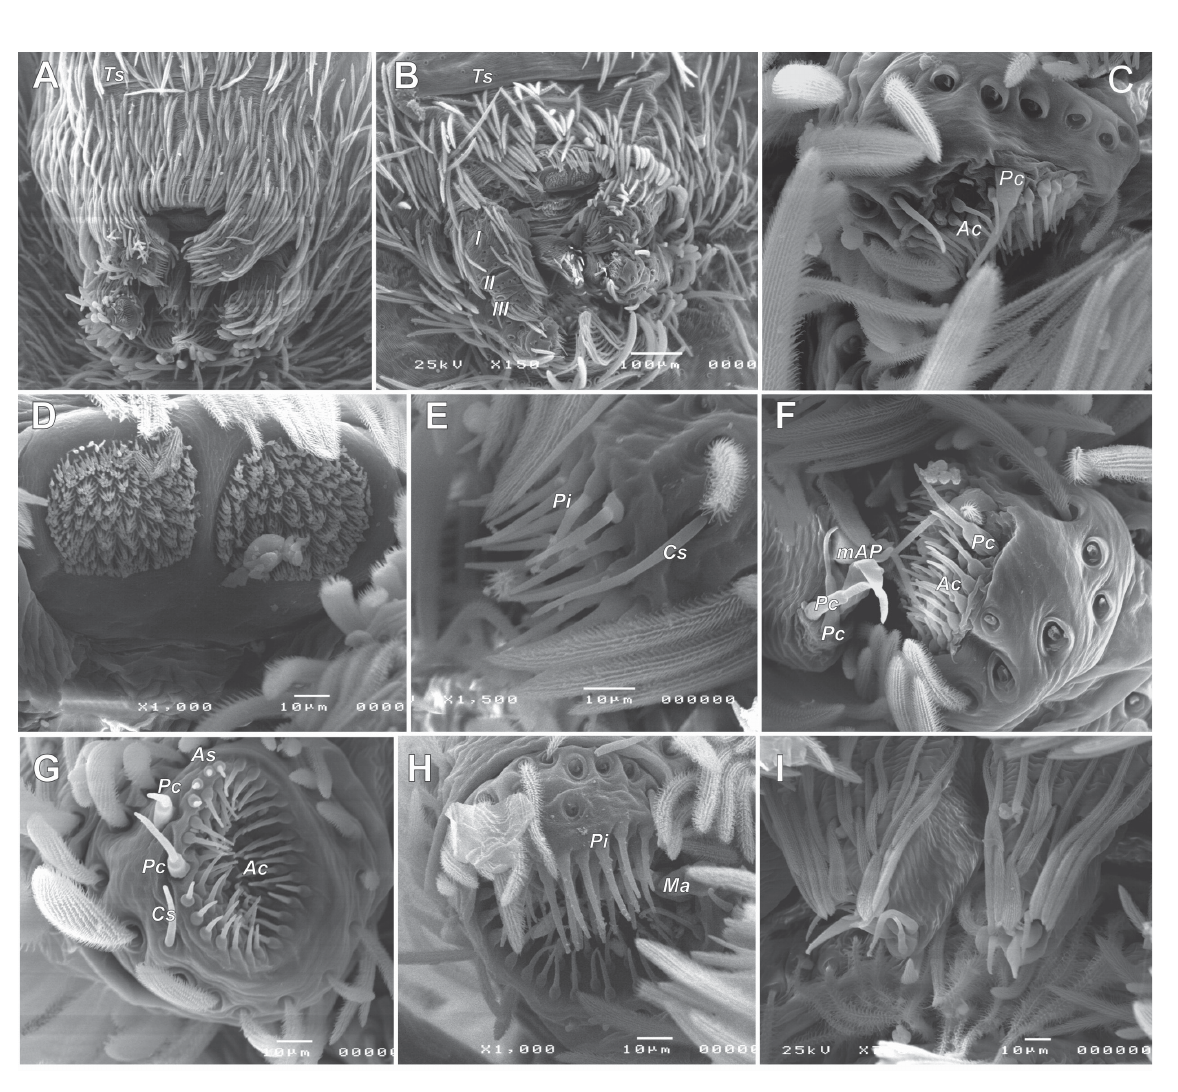
Fig. 4. Spinneret morphology of Zaitunia martynovae (Andreeva & Tyshchenko, 1969), adult ♀ from Gandzhina. A–B . Spinnerets and tracheal spiracle. C . right posterior lateral spinneret. D . Cribellum. E . Left anterior lateral spinneret. F . Left posterior median and lateral spinnerets. G . right posterior lateral spinneret, frontal. H . right anterior lateral spinneret. I . Posterior median spinnerets. abbreviations: see Material and methods. Scale bars: A–B = 100 μm; C–I = 10